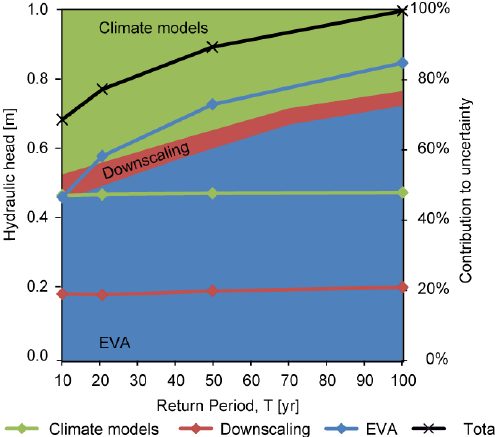
Fig. 10. Propagation of uncertainty for estimation of future extreme groundwater levels. Uncertainty from climate models, downscaling and Gumbel distribution are shown with absolute values (left axis) and percentage contribution (right axis) with background colouring.